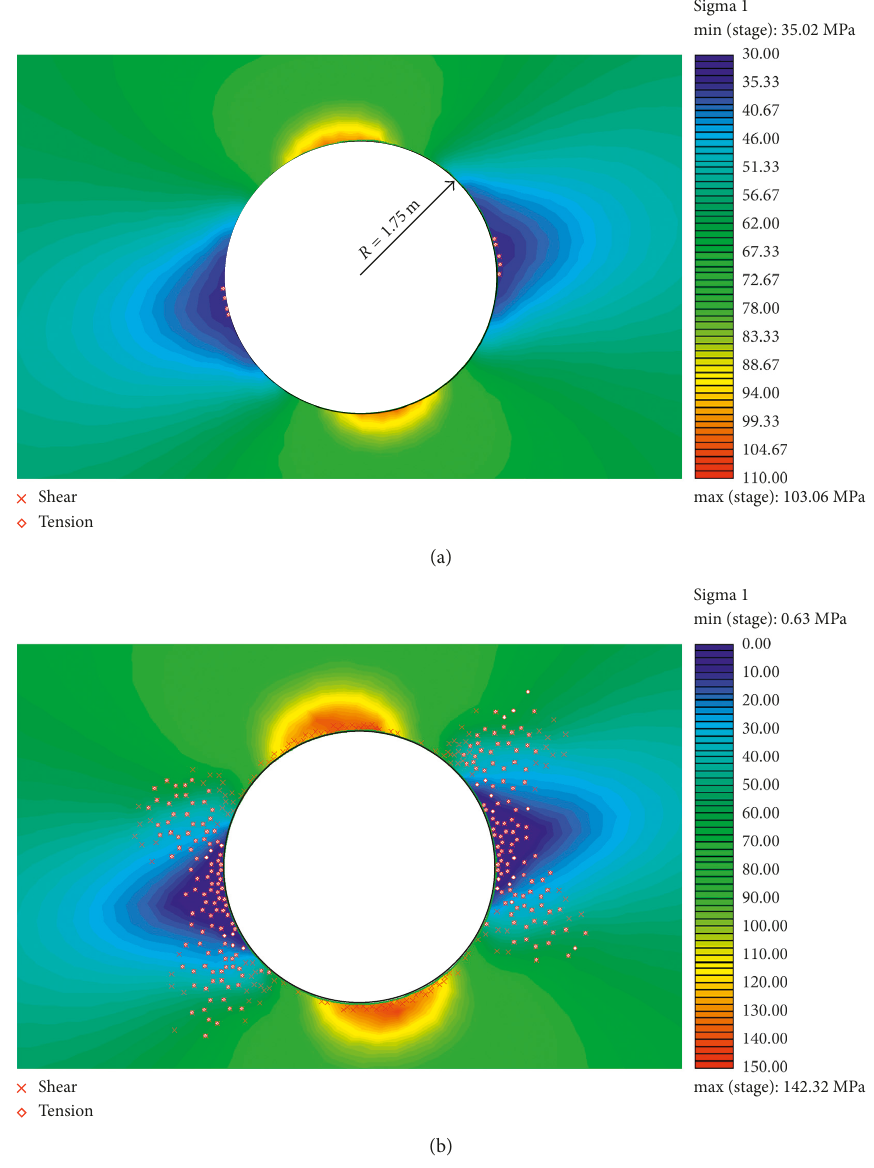
Figure 7: Major principal stress 1 contours of the intact FEM model using the Hoek–Brown criterion (GSI (cid:31) 80). (a) Elastic response of the model at 60% of the induced stresses (tunnel advancing) and (b) final model state after the completion of the excavation. Yielded elements in shear ( ) and in tension ( ) are σ × ○